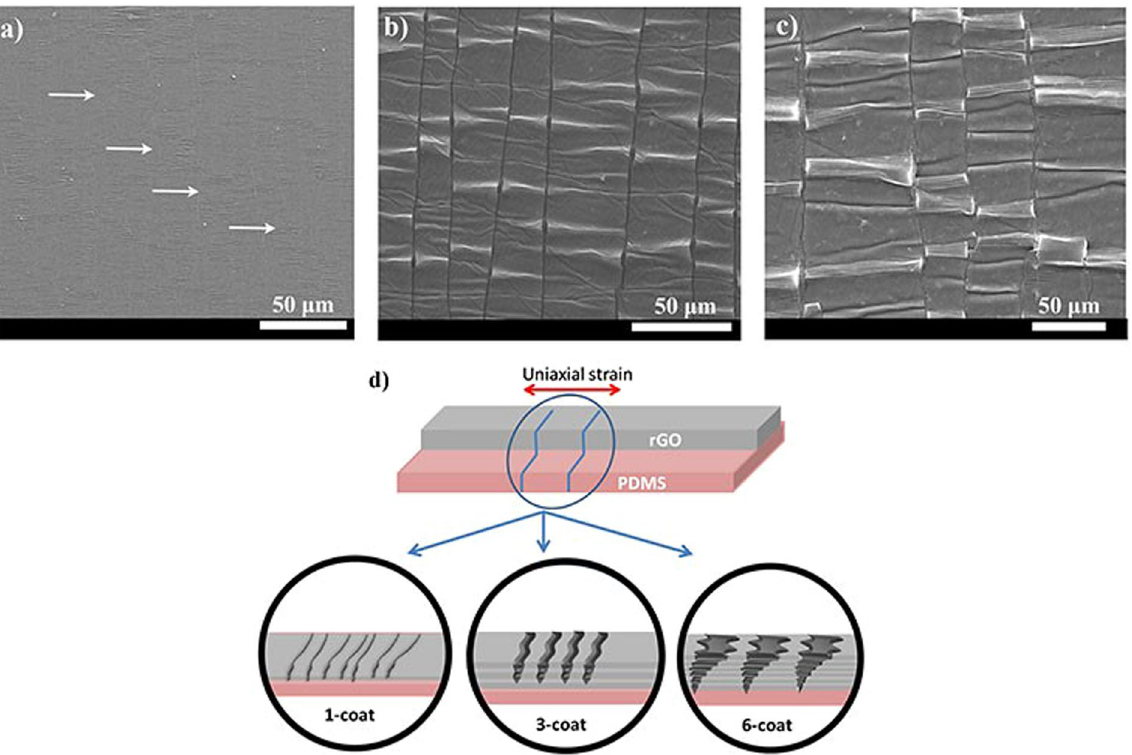
Figure 3. SEM images for ( a ) 1-coat (arrows indicate the position of cracks) ( b ) 3-coat ( c ) 6-coat rGO films on PDMS substrate at 5% applied strain. ( d ) Schematic diagram to illustrate the thickness dependent crack formation in rGO films under uniaxial